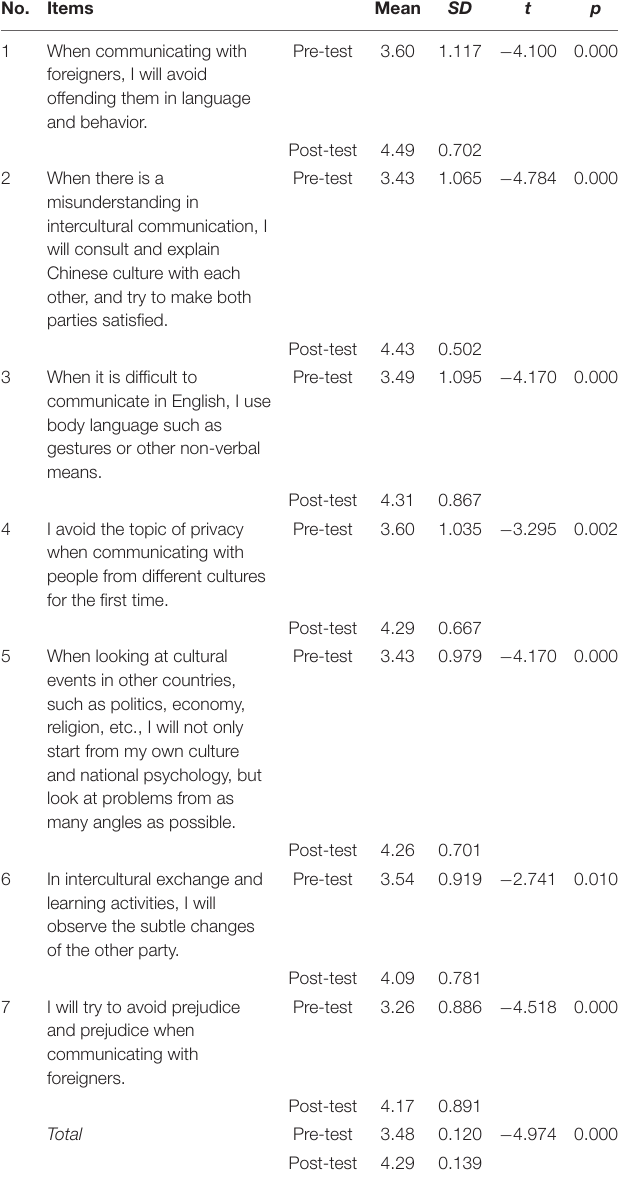
TABLE 3 | Skills of discovery and interaction dimension of